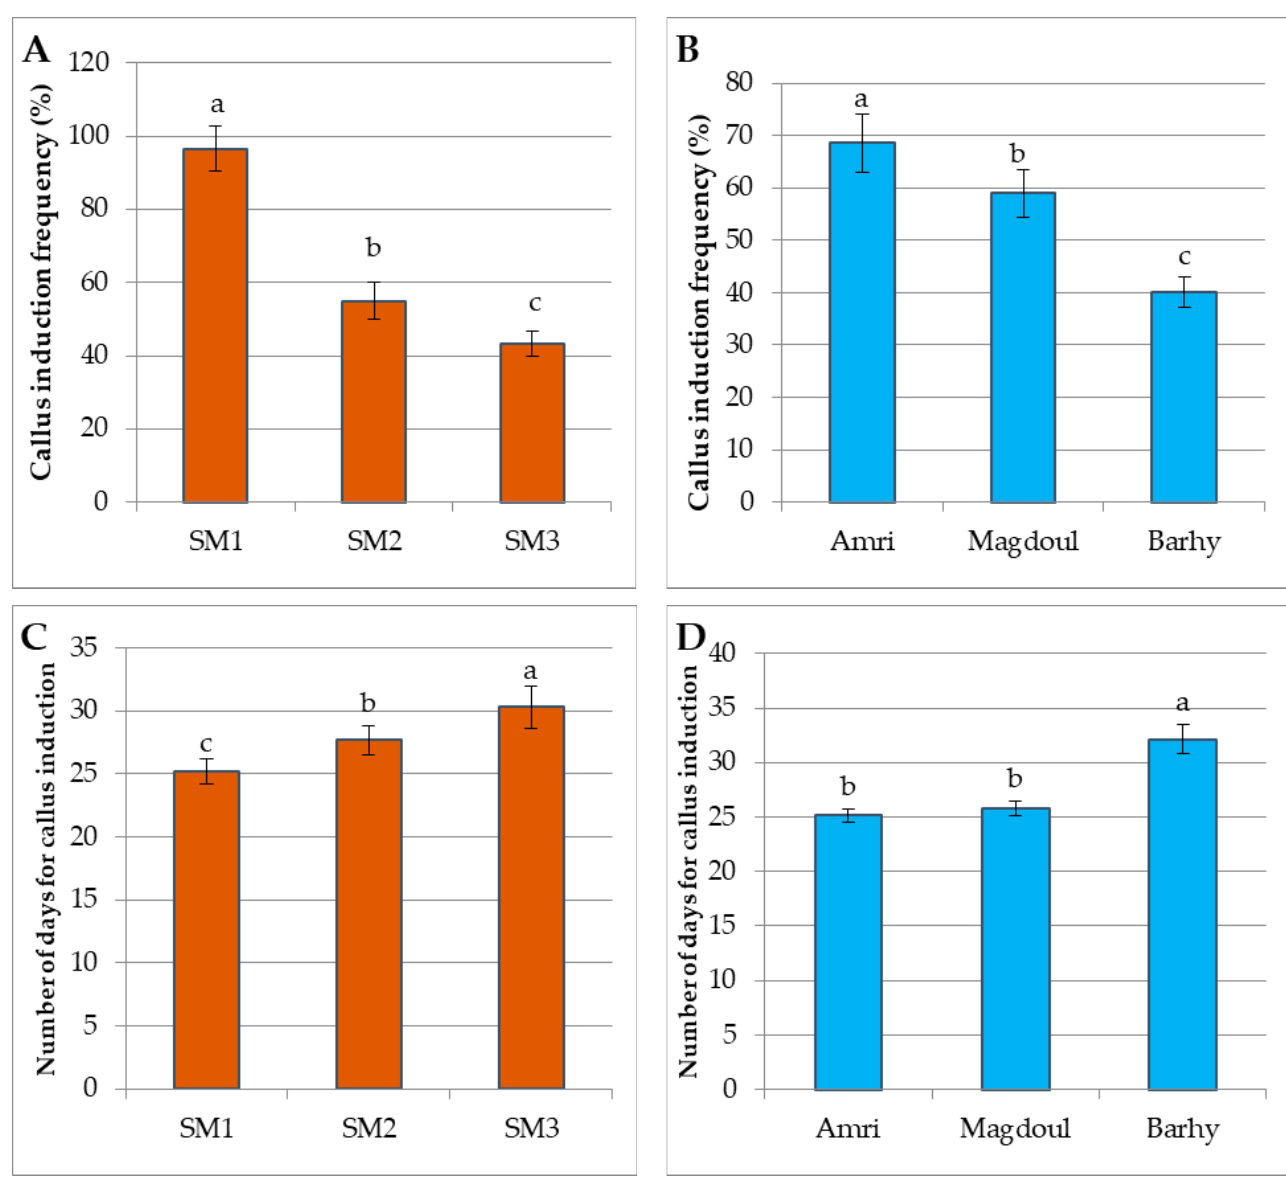
Figure 1. ( A ). The percentages of callus induction frequency in the three varieties (Amri, Magdoul and Barhy). ( B ). The percentages of callus induction frequency of the three starting media (SM1, SM2 and SM3). ( C ). The number of days for callus induction on the three starting media (SM1, SM2 and SM3). ( D ). The number of days for callus induction in the three varieties (Amri, Magdoul and Barhy. Note: Charts with the same letters are not statistically different at p < 0.05. Different letters denote a significant difference among culture media at p <